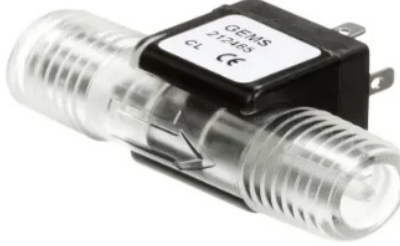
Figure 2. FT-210 series turbine flow sensor.